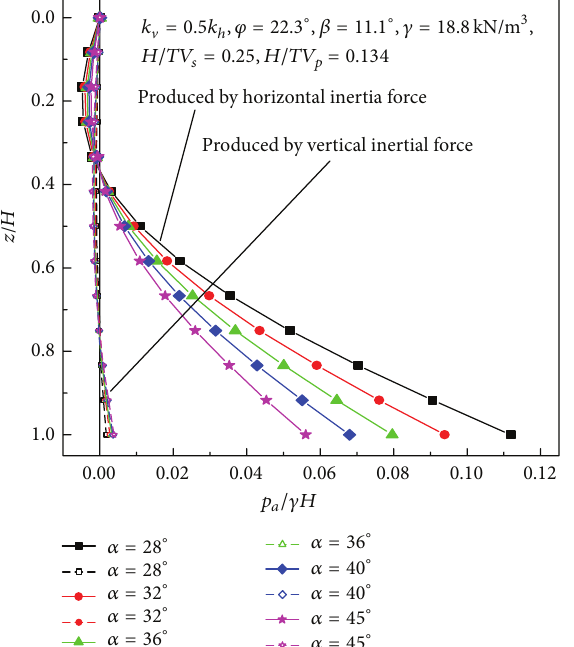
Figure 6: Comparisons of dynamic earth pressures produced by the horizontal inertia force and the vertical inertial force.